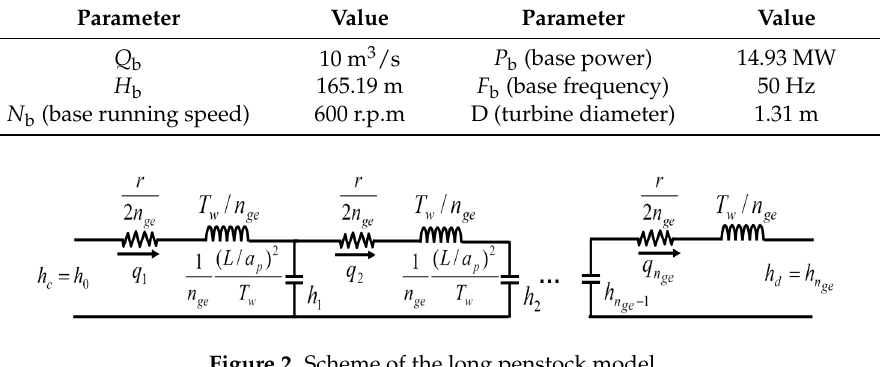
Figure 1. Block diagram of the dynamic model. All variables are expressed in p.u. values with respect to the base values included in Table 1. Table 1. Model base values.